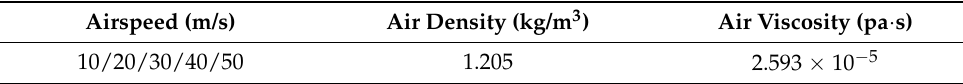
Table 2. Boundary conditions.